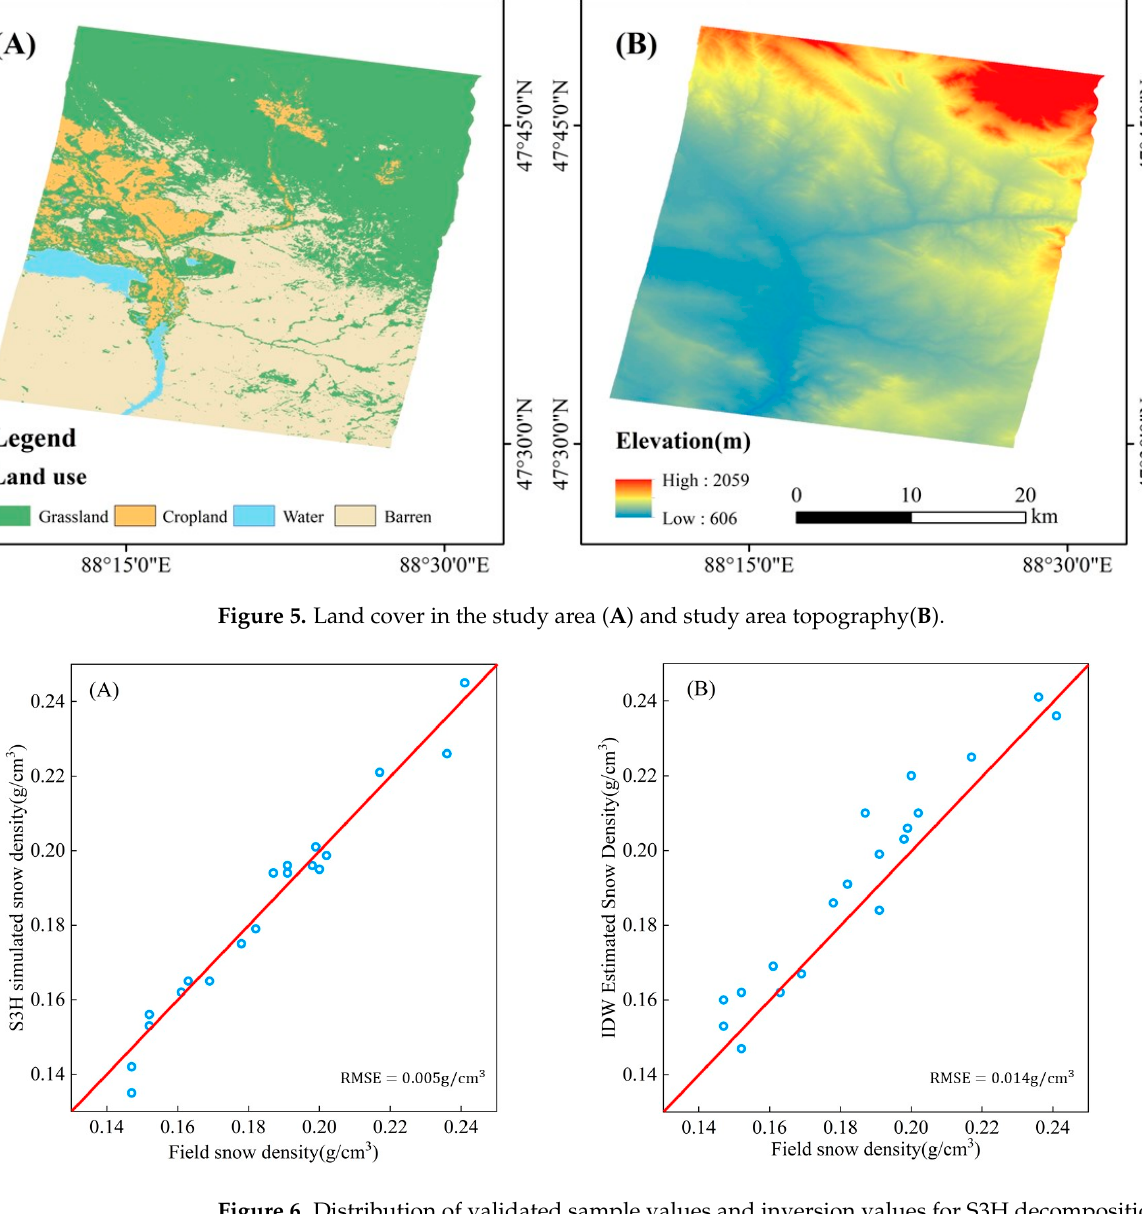
Figure 6. Distribution of validated sample values and inversion values for S3H decomposition ( A ) and IDW interpolation ( B ) of snow density.